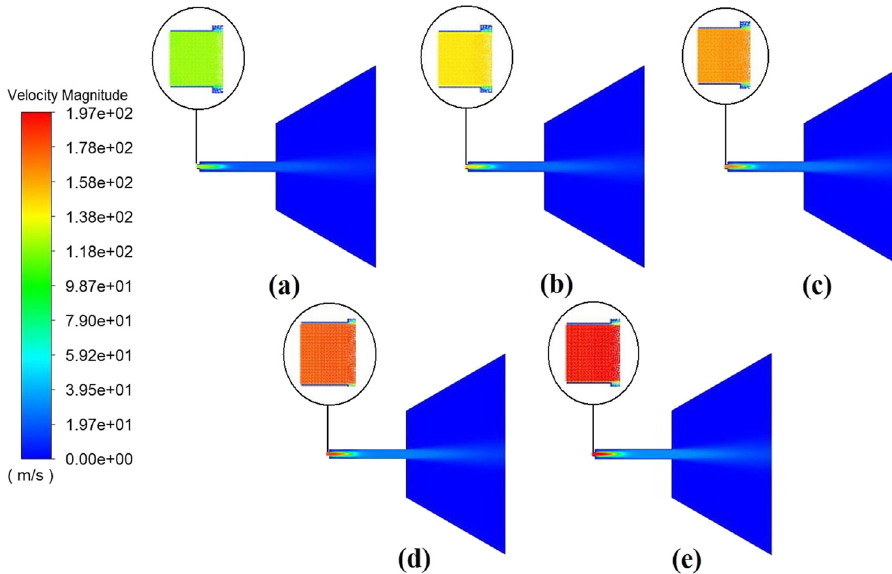
Figure 5: Contours of velocity fi eld under di ff erent air pressures: ( a ) 0.007 MPa, ( b ) 0.01 MPa, ( c ) 0.013 MPa, ( d ) 0.016 MPa, ( e ) 0.019 MPa.